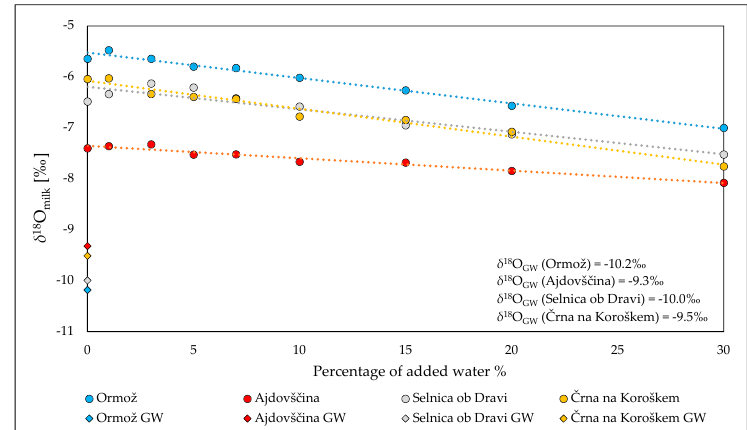
Figure 6. The relationship between δ 18 O milk values and percentage of added water to authentic milk samples from different locations with different δ 18 O GW . Measured δ 18 O milk are significantly ( p < 0.05) related to the δ 18 O GW in a regression analysis. The correlation coefficients between δ 18 O milk values and added water were 0.98, 0.89, 0.98 and 0.96 for Ormož, Selnica ob Dravi, Č rna na Koroškem and Ajdovš č ina, respectively.